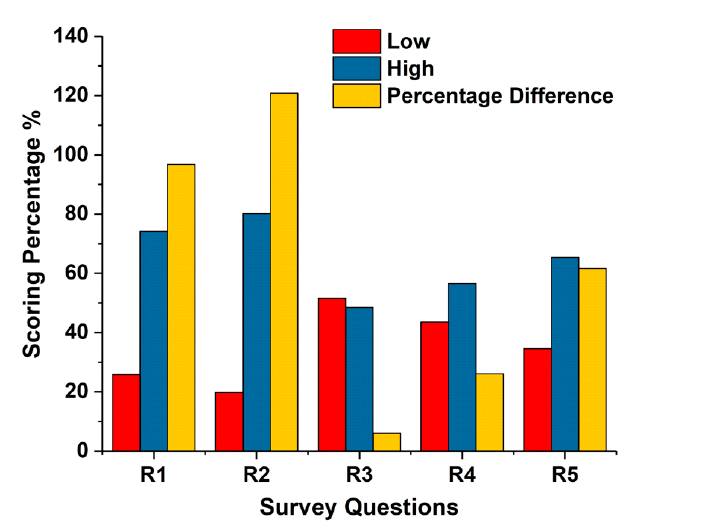
Figure 1. Radiologists’ knowledge of CT radiation risk.